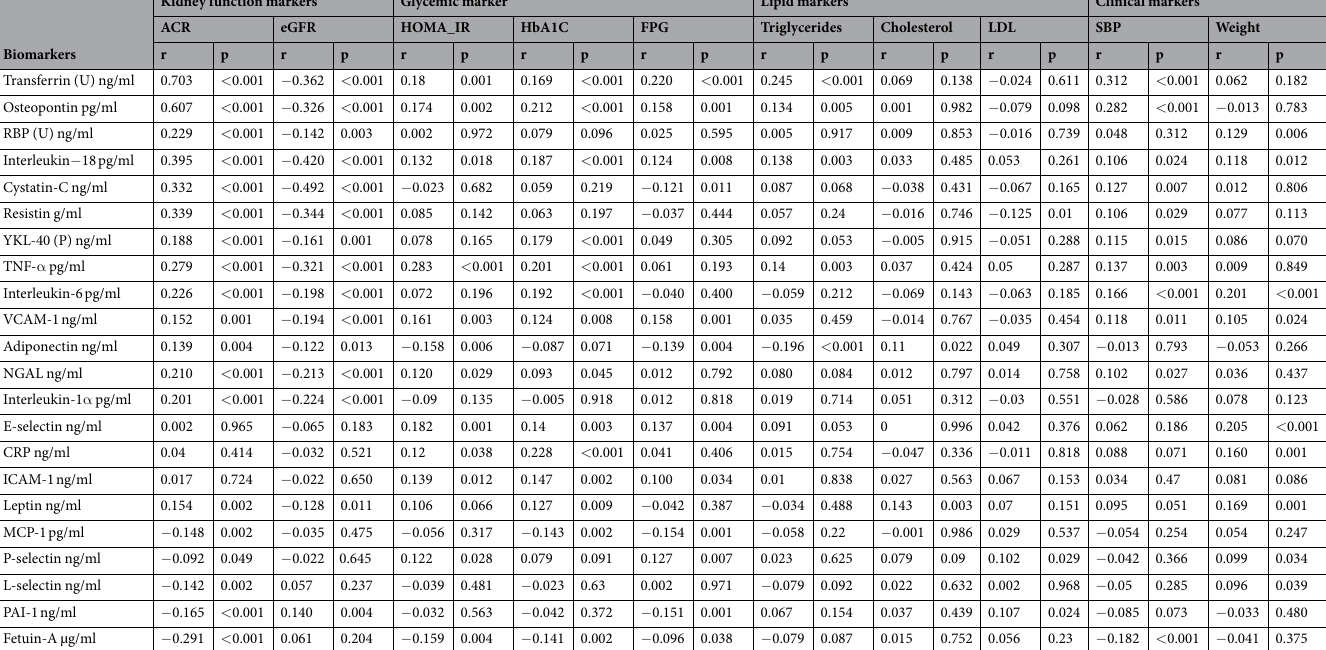
Table 2. Correlation coefficient (r) between the 22 nephrobiomarkers and the studied patients’